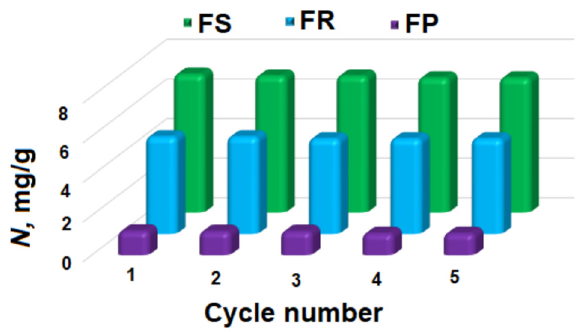
Figure 7. Repeated sorption cycles.